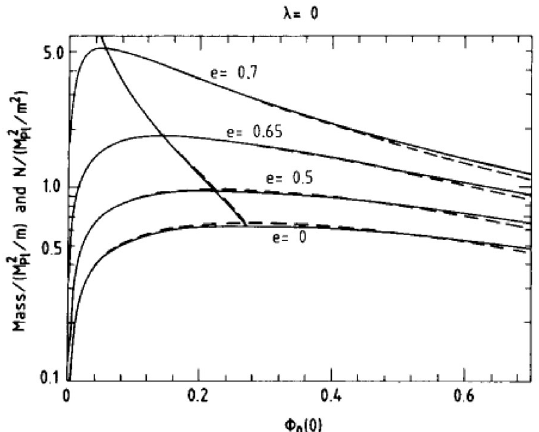
Fig. 5 The mass (solid) and the number of particles (dashed) versus central scalar value for charged boson stars with four values of ~ e as de fi ned in Sect. 3.3. The mostly-vertical lines crossing the four plots indicate the solution for each case with the maximum mass (solid) and maximum particle number (dashed). Reproduced with permission from Jetzer